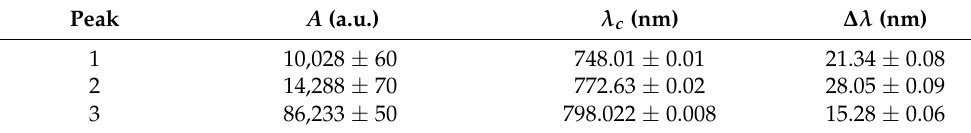
Figure 4. Spectrum of Rb-Ar obtained integrating the fluorescence for λ emission > 850 nm, and chang- ing the excitation of the laser pump in the NIR range. Blue dots are experimental data, while the gray line is the three Lorentzian fits obtained. Table 2. Peak parameters obtained from the fits of Figure 4 ( λ emission > 850